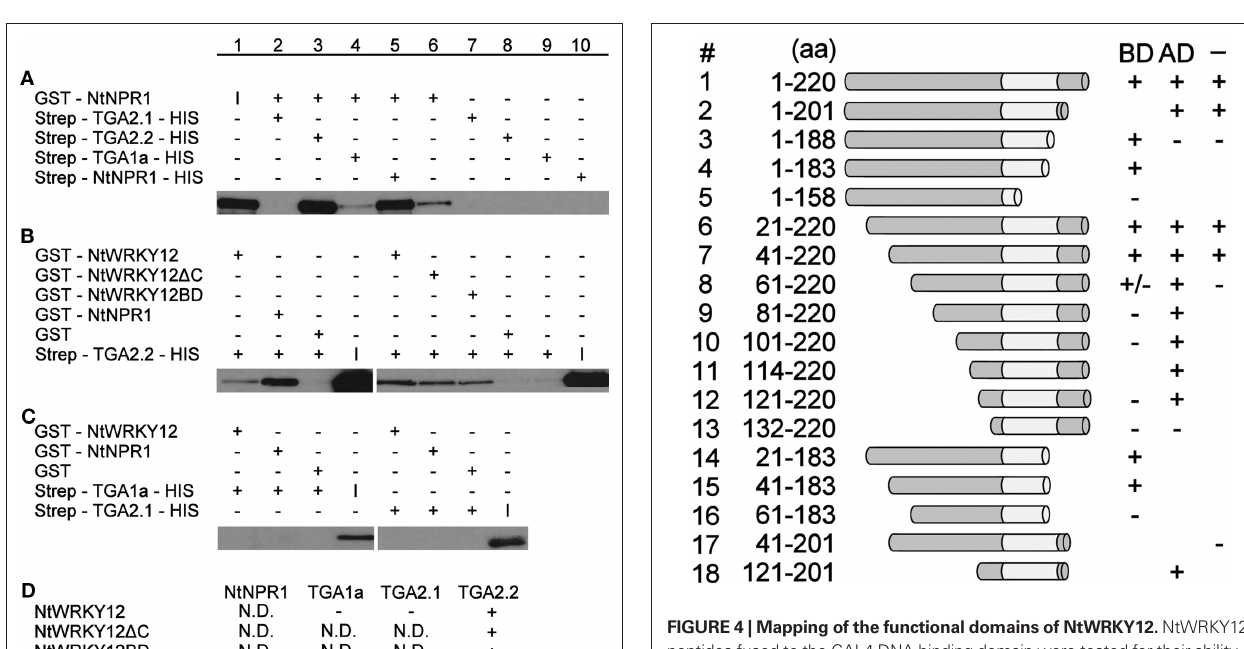
FiGuRe 4 | Mapping of the functional domains of NtWRKY12. NtWRKY12 peptides fused to the GAL4 DNA-binding domain were tested for their ability to activate GAL4::Ade gene expression in yeast (results with these constructs are indicated in column BD). NtWRKY12 peptides fused to the GAL4 activation domain were tested for their ability to bind to PR-1a promoter fragment controlling the HIS marker gene (results with these constructs are indicated in column AD). Unfused NtWRKY peptides were assayed for binding to the PR-1a promoter and activation of the HIS gene under its control (results with these constructs are indicated in column –). Column aa shows the ranges of the amino acid residues of the respective NtWRKY12 peptides. Plus signs in columns BD, AD, and – indicate growth of yeast; minus signs indicate absence of growth of yeast. The absence of plus or minus signs: